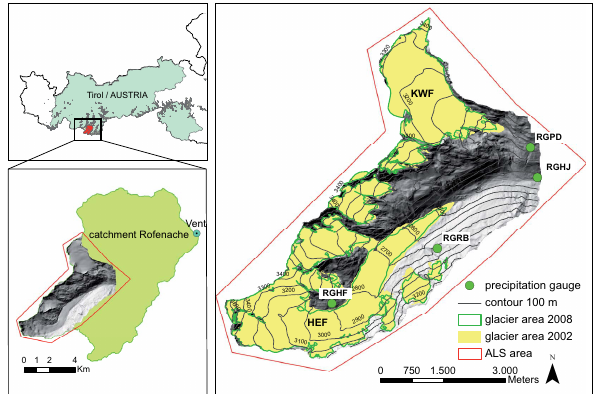
Fig. 1. Map of the investigated catchment. The village Vent, where the automatic weather station is located, the cumulative rain gauges Hochjochhospiz (RGHJ), Proviantdepot (RGPD), Rofen- berg (RGRB) and Hintereisferner (RGHF) are marked. The two glaciers Hintereisferner (HEF) and Kesselwandferner (KWF) are